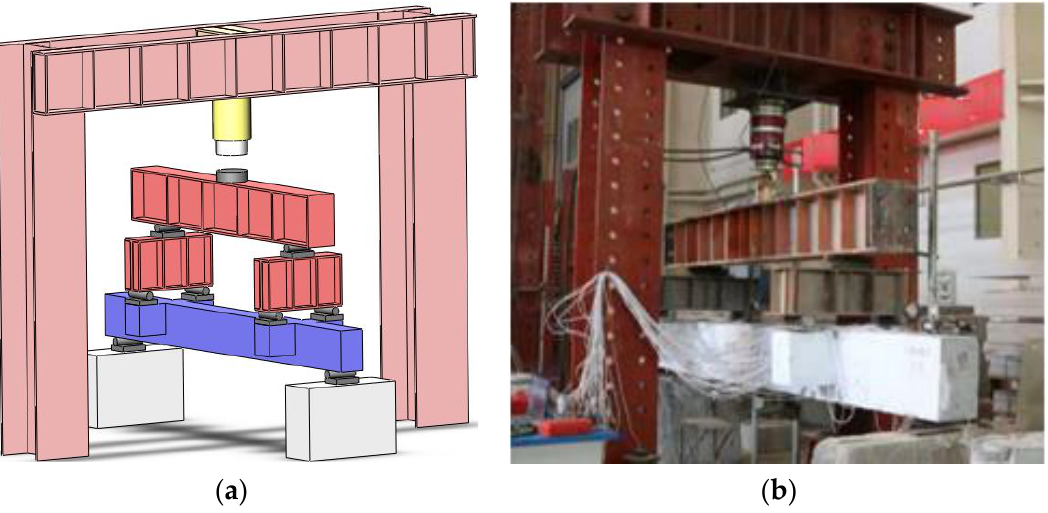
Figure 5. Static load test device of indirectly loaded beam (dimension in mm): ( a ) loading device and ( b ) loading site.